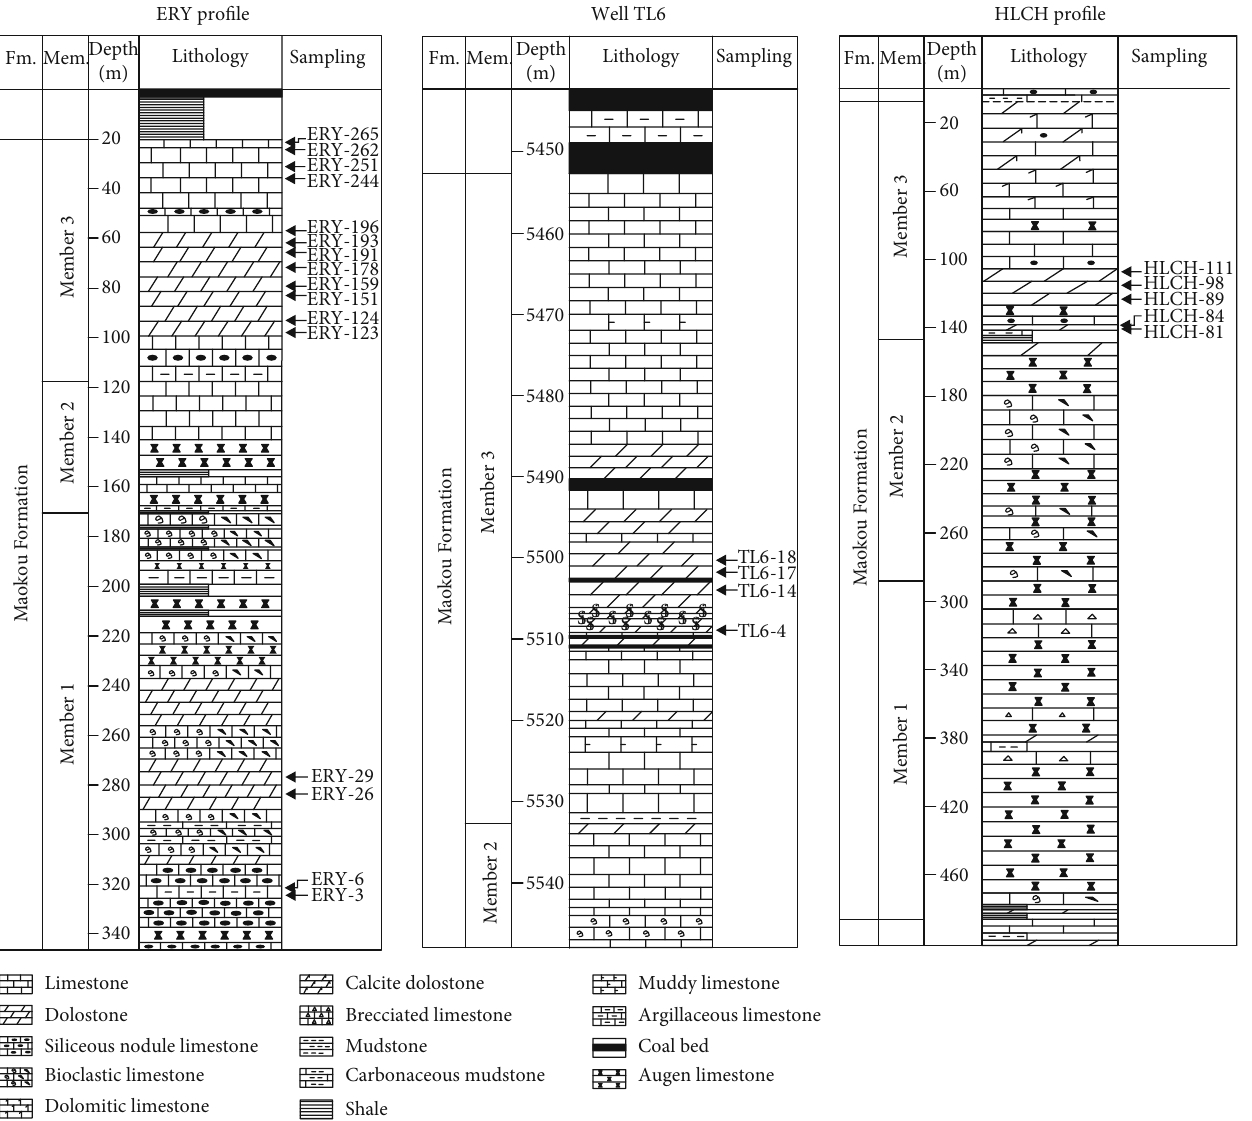
Figure 2: The comprehensive stratigraphic columns showing lithology and sampling sites of the Maokou